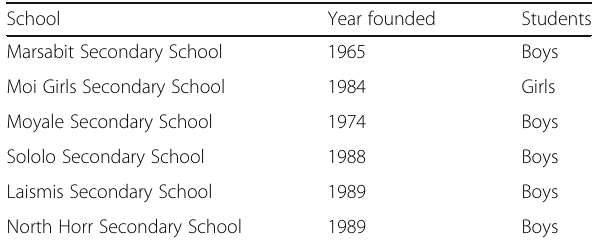
Table 1 Number of secondary schools in Marsabit District, 1965 to